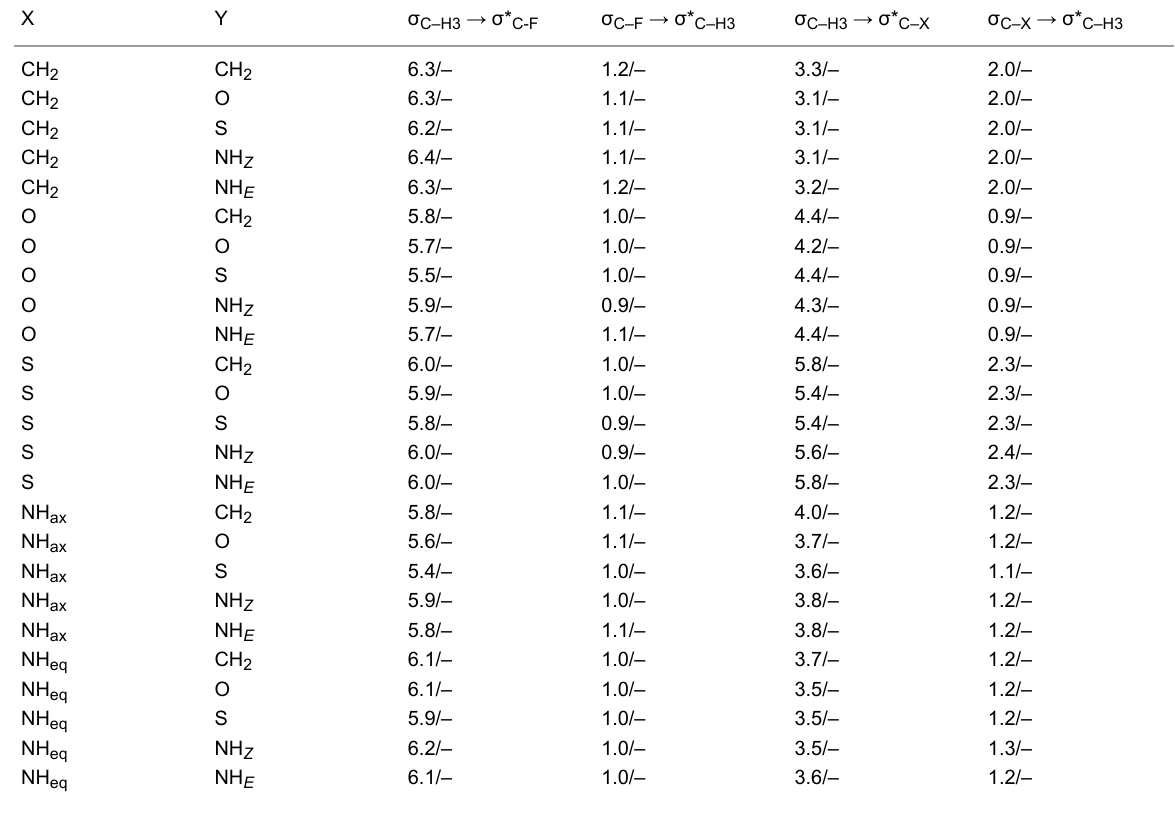
Table 3: Important antiperiplanar hyperconjugative interactions (given for axial/equatorial, in kcal mol − 1 ). X Y CH 2